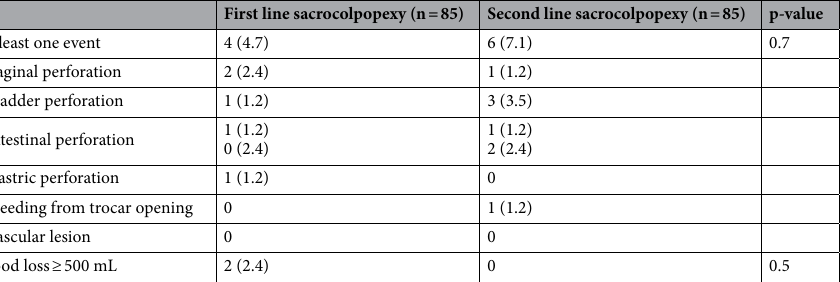
Table 3. Comparison of intraoperative complications between first line and second line sacrocolpopexies. Values are mean ± deviation standard or number of cases (percentage). n number of cases, mL